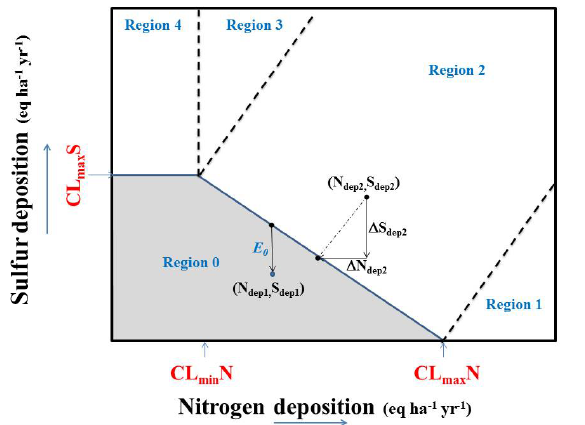
Figure 2. Critical load function, showing exceedance Regions 1 through 4 and the “below exceedance” Region